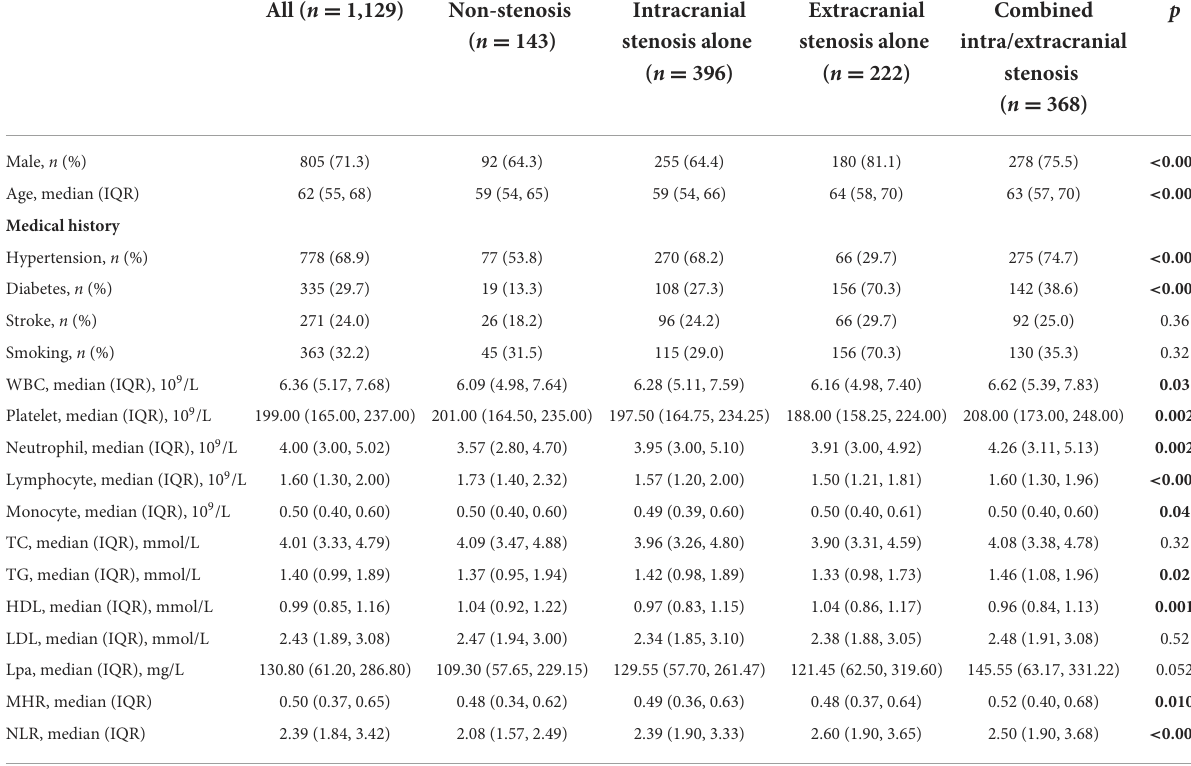
TABLE 1 Comparison of factors among the patients with different distribution of atherosclerotic stenosis. All ( n =